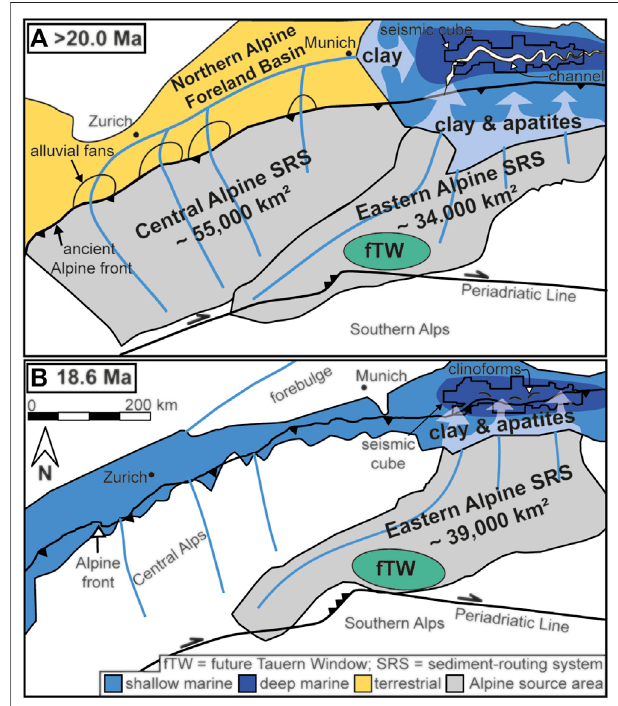
FIGURE 7 | Paleogeographic reconstruction of the Rupelian to Burdigalian SRSs in the Alps following Winterberg (2019). (A) From 28 to 19 Ma eastward sediment routing persisted in the NAFB. (B) Transport direction changed to a dominantly northward sediment transport after the fl ooding of the NAFB at 19 Ma. The Central Alpine SRS was cut off from the Upper Austrian NAFB which signi fi cantly reduced the sediment- source